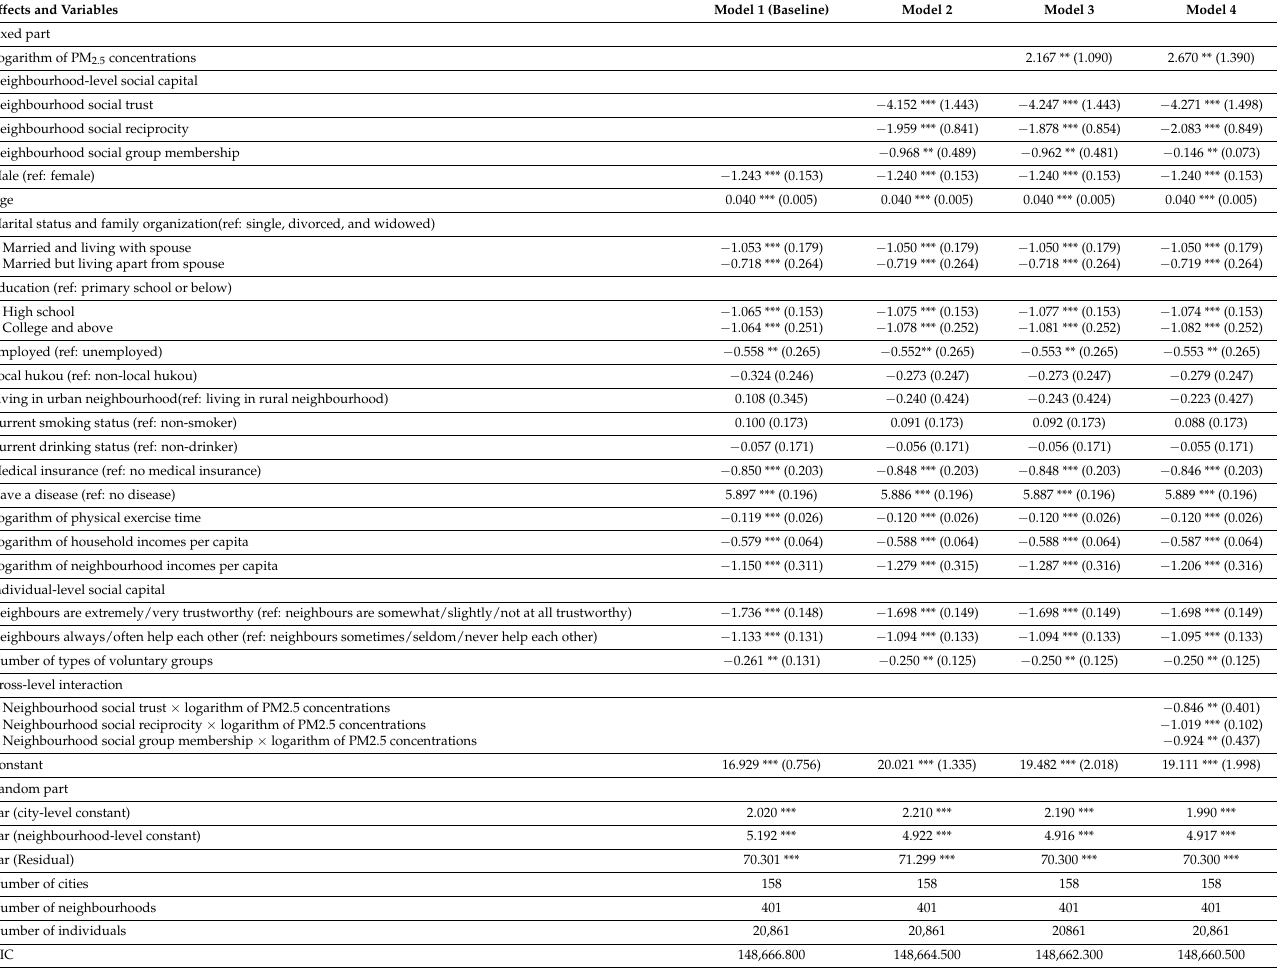
Table 2. Multilevel liner regression coefficients for the effects of PM2.5 concentrations, social capital, and individual characteristics on depressive